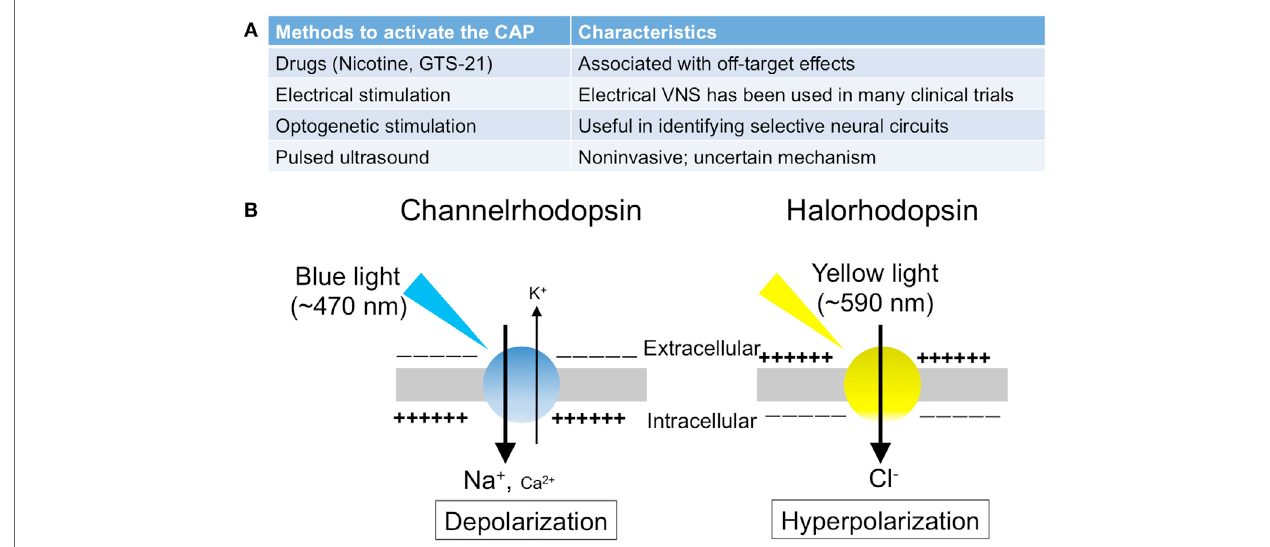
FiGURe 2 | The summary of the methods to activate the cholinergic anti-inflammatory pathway (CAP). (A) The list of the methods to activate the CAP. (B) Photosensitive ion transporters (used for optogenetic stimulation). When blue (yellow) light is applied to neurons expressing channelrhodopsin (halorhodopsin), the opsin functions as a non-selective cation channel (a chloride pump), resulting in excitation (inhibition) of the